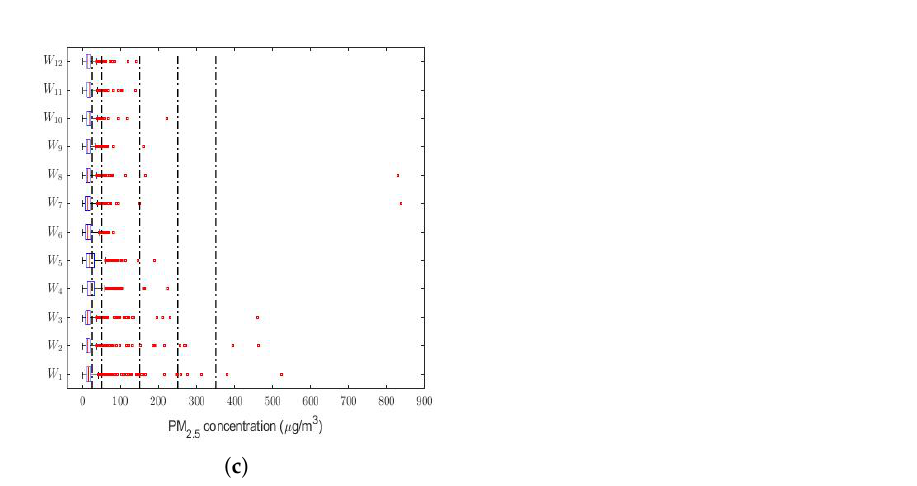
Figure 3. Multiple box plots for months, days, and day hours every two hours. The outliers are represented by red circles, and the 5 vertical dashed lines in each figure indicate the intervals of air pollution levels: desirable level [0, 25 µg/m 3 ), acceptable level [25 µg/m 3 , 50 µg/m 3 ), caution level [50 µg/m 3 , 150 µg/m 3 ), alert level [150 µg/m 3 , 250 µg/m 3 ), alarm level [250 µg/m 3 , 350 µg/m 3 ), and emergency level [350 µg/m 3 , ∞ ). ( a ) Box plots of the months: January ( Y 1 ), . . ., December ( Y 12 ). ( b ) Box plots of the days: Monday ( Z 1 ), . . ., Sunday ( Z 7 ). ( c ) Box plot of the day hours every two hours: 0:00–1:00 ( W 1 ), . . ., 22:00–23:00 ( W 12